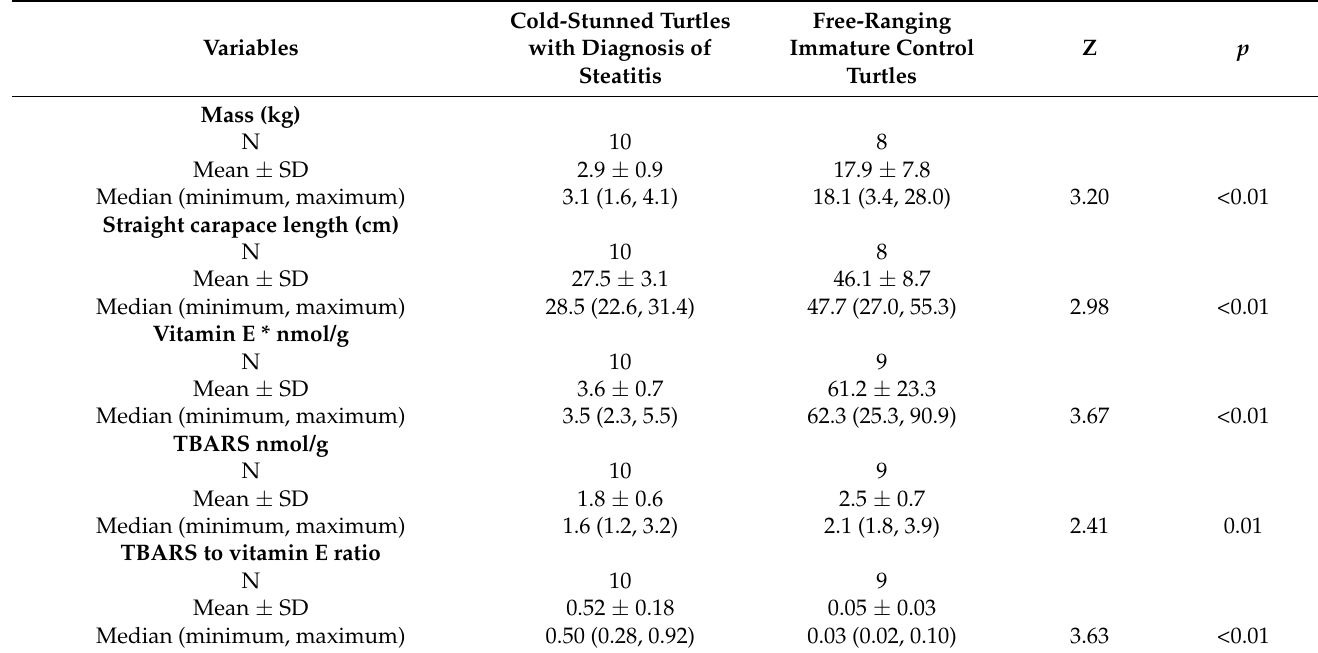
Table 3. Mass, straight carapace length, and plasma concentrations of α -tocopherol (vitamin E), thiobarbituric acid reactive substances (TBARS), and TBARS to vitamin E ratios of cold-stunned Kemp’s ridley sea turtles ( Lepidochelys kempii ) affected with steatitis compared to those of free-ranging immature control